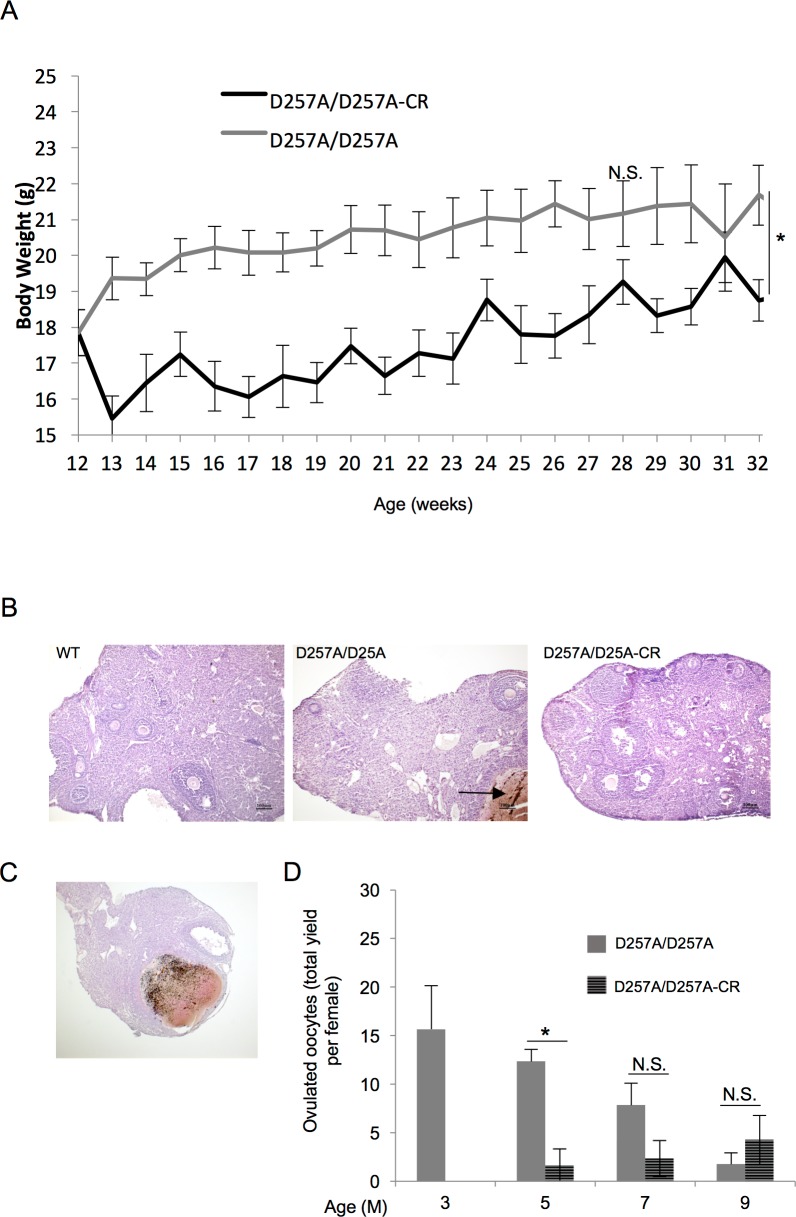
Body weight and ovarian characteristics following CR in POLGD257A/257A female mice.A. Body weight was decreased following the onset of CR. AL-fed POLGD257A/257A mice (D57A/D57A) denoted by grey line; POLG on a CR diet (D57A/D57A-CR) denoted by black line (error bars shown at selected age intervals for clarity, n = 3–10 mice per group, * indicates P < 0.05, N.S., not significant). B. Histological sections of representative ovaries from 7-month old WT, AL-fed POLGD257A/257A, and POLGD257A/257A fed a CR diet demonstrates normal ovarian follicle distribution. Of note, ovarian cysts were present in approximately 50% ovaries collected from POLGD257A/257A mice, regardless of dietary status (ovarian cyst denoted by black arrow; ovaries from 4 out of 8 POLGD257A/257A and 5 out of 8 POLGD257A/257A-CR harbored cysts). C. Representative histological ovarian section of a POLGD257A/257A mouse containing a large ovarian cyst. D. CR reduces the number of ovulated oocytes at 5 and 7 months of age in POLGD257A/257A mice (3 months n = 3; 5-, 7-, 9-month n = 6).